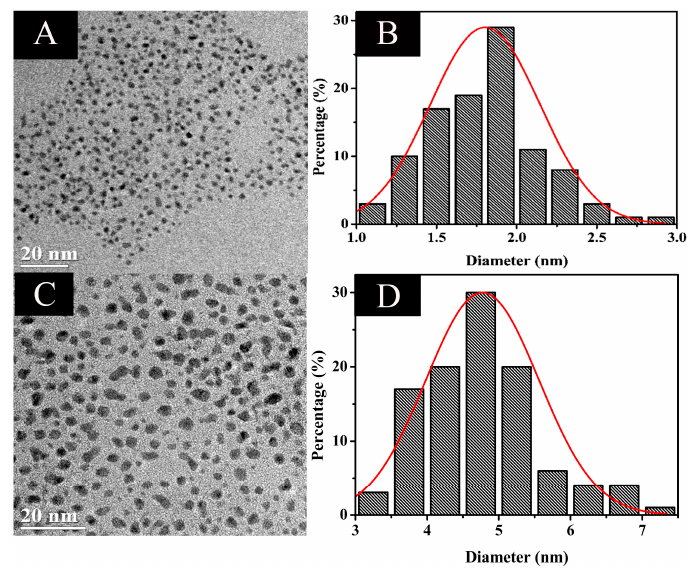
Figure 3. Representative high resolution transmission electron microscopy (HRTEM) images of the as-synthesized luminescent Au NCs ( A ); the particle-size distribution histogram of Au NCs ( B ); Au NCs in the presence of 50 μ M Cd 2+ ( C ); and particle-size distribution histogram ( D ).